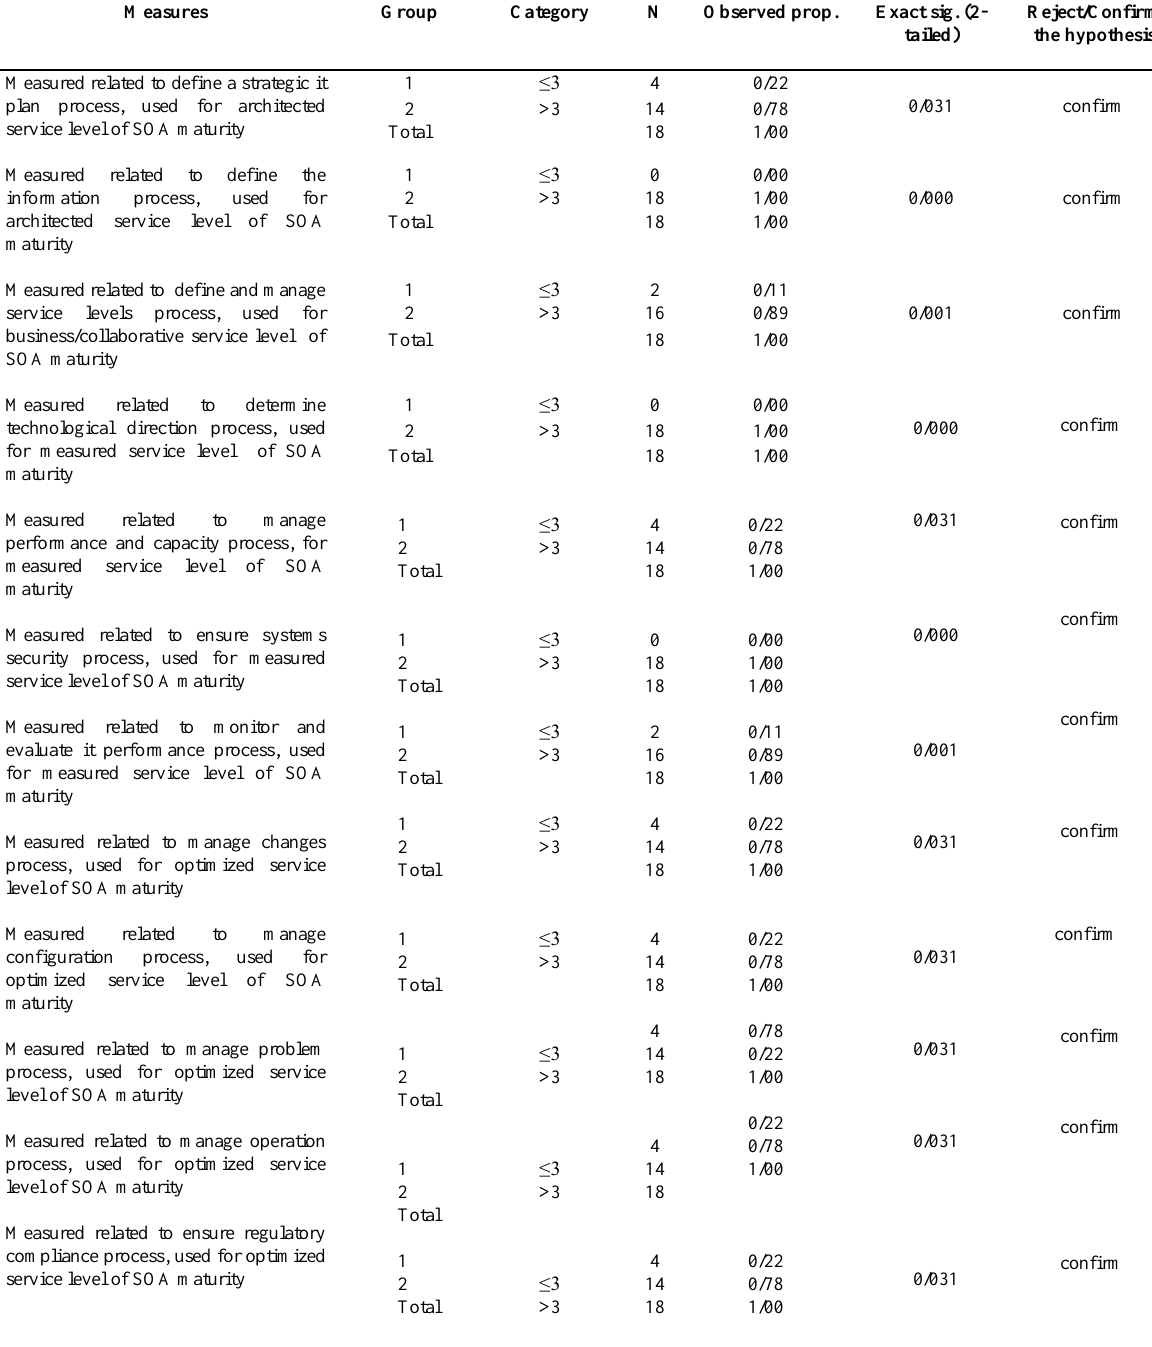
Table 8: Result of testing hypothesis of C section (sig. level